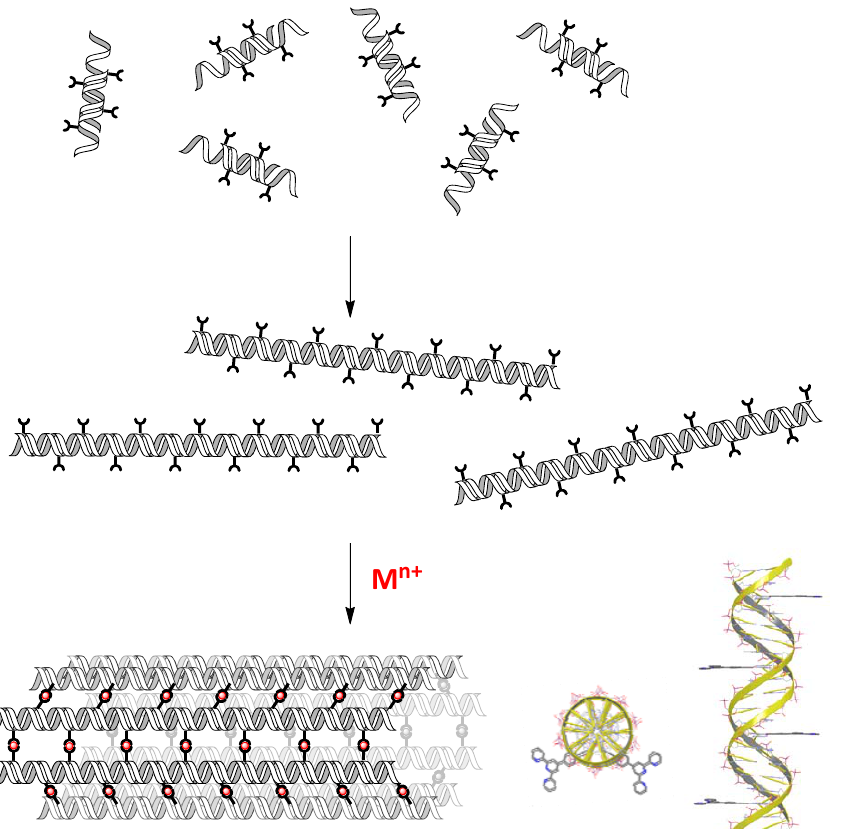
Figure 5. Putative representation of the annealing of long DNA strands through sticky-end recognition and formation of tubular assemblies by metal